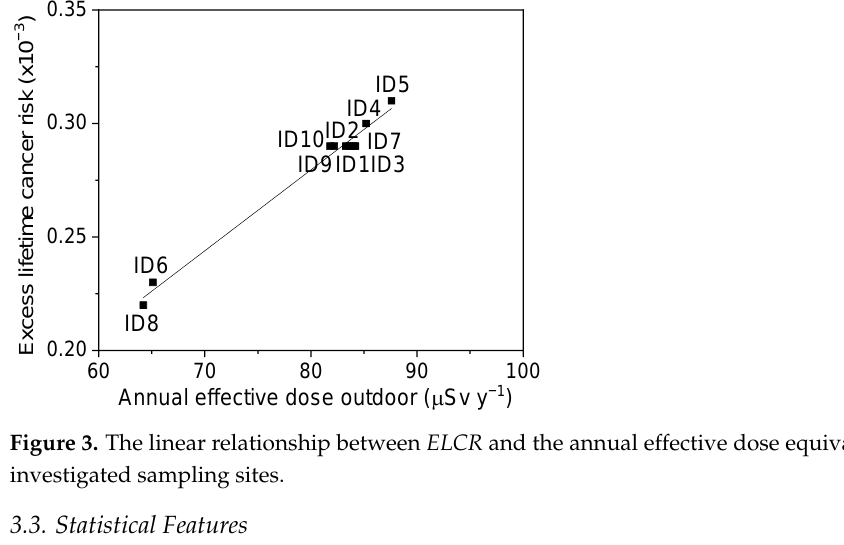
Table 6. p -value results of different statistic tests used to verify the normal distribution of data. Variables